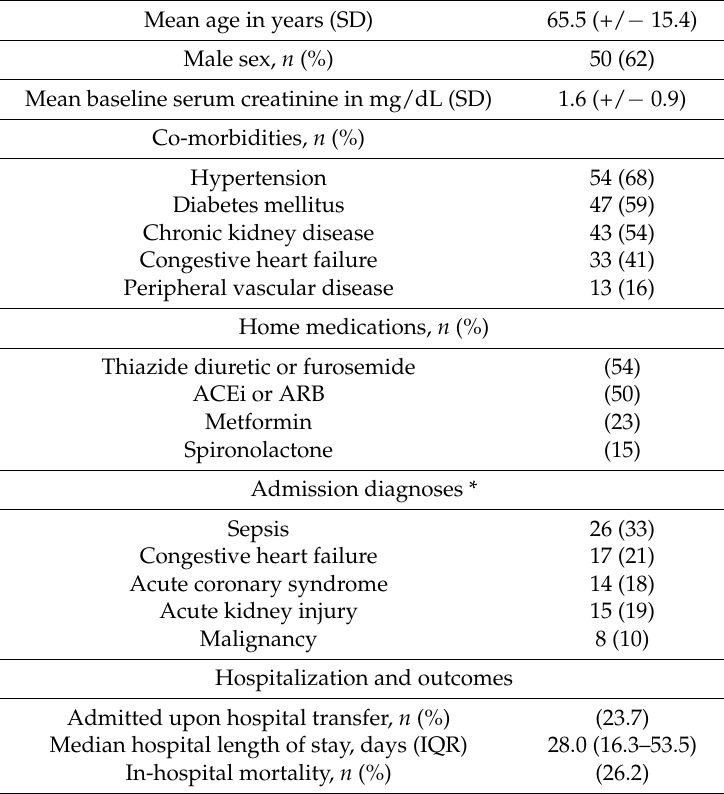
Table 1. Baseline patient characteristics ( n = 80).